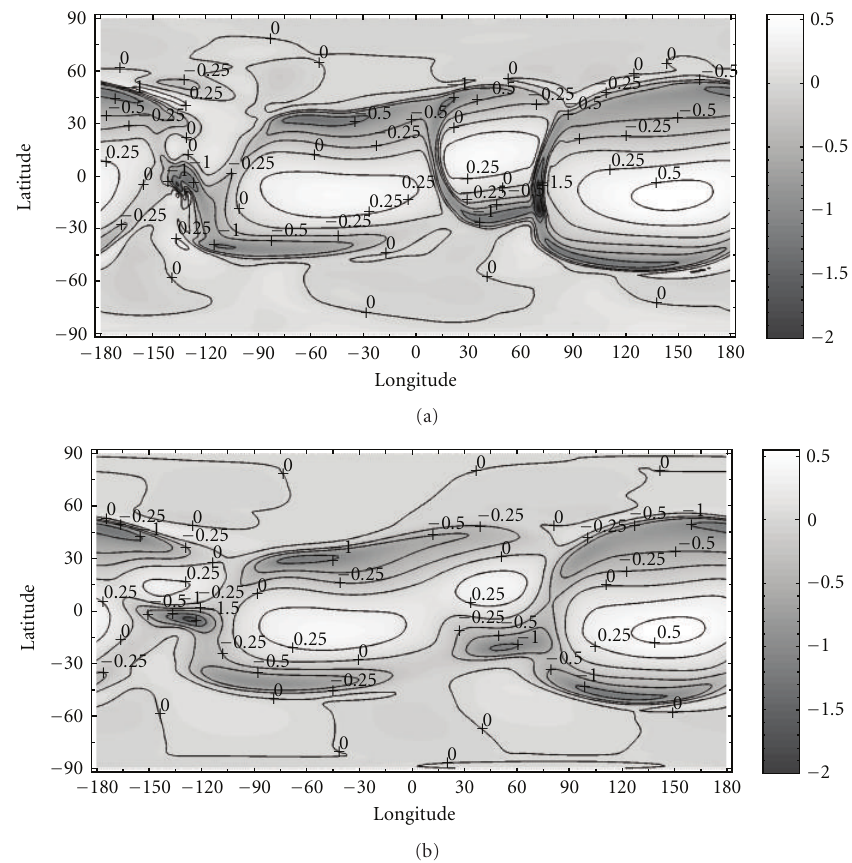
Figure 13: The same as in Figure 12 but at the altitude of 90